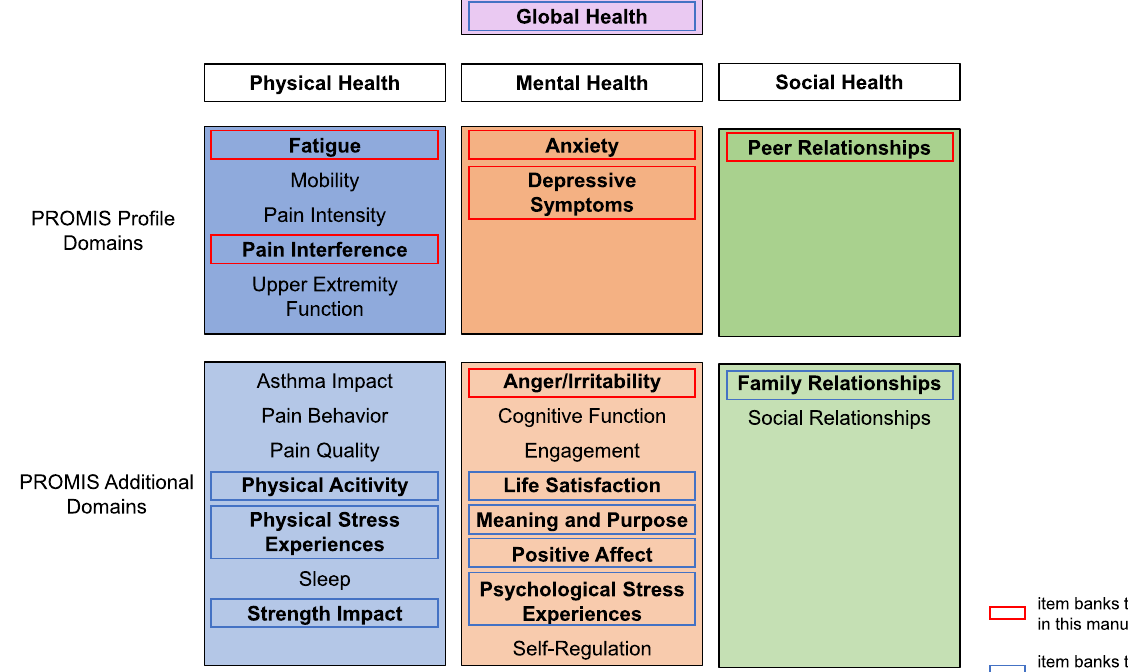
Fig. 1 PROMIS Conceptualization of pediatric